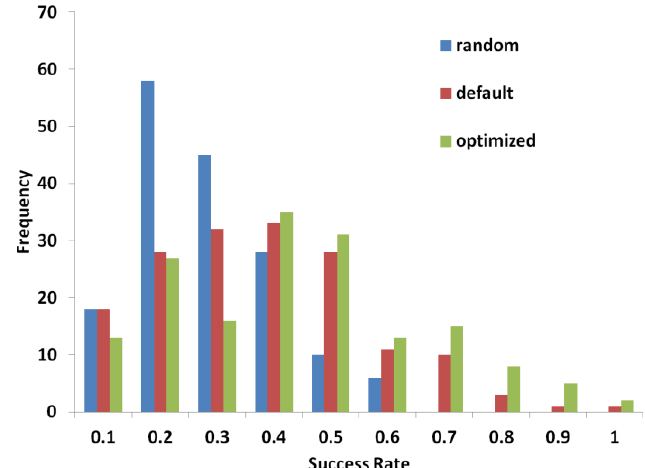
Figure 3. Distribution of patch matching success rate. Frequency on the y -axis counts the number of individual protein–ligand complexes of a success rate. The distance threshold was set to 5.0